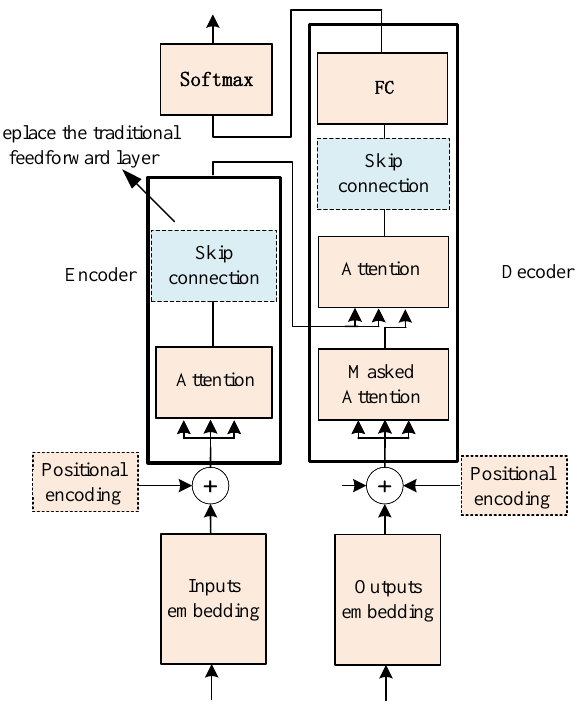
Figure 3. A Transformer structure containing double skip